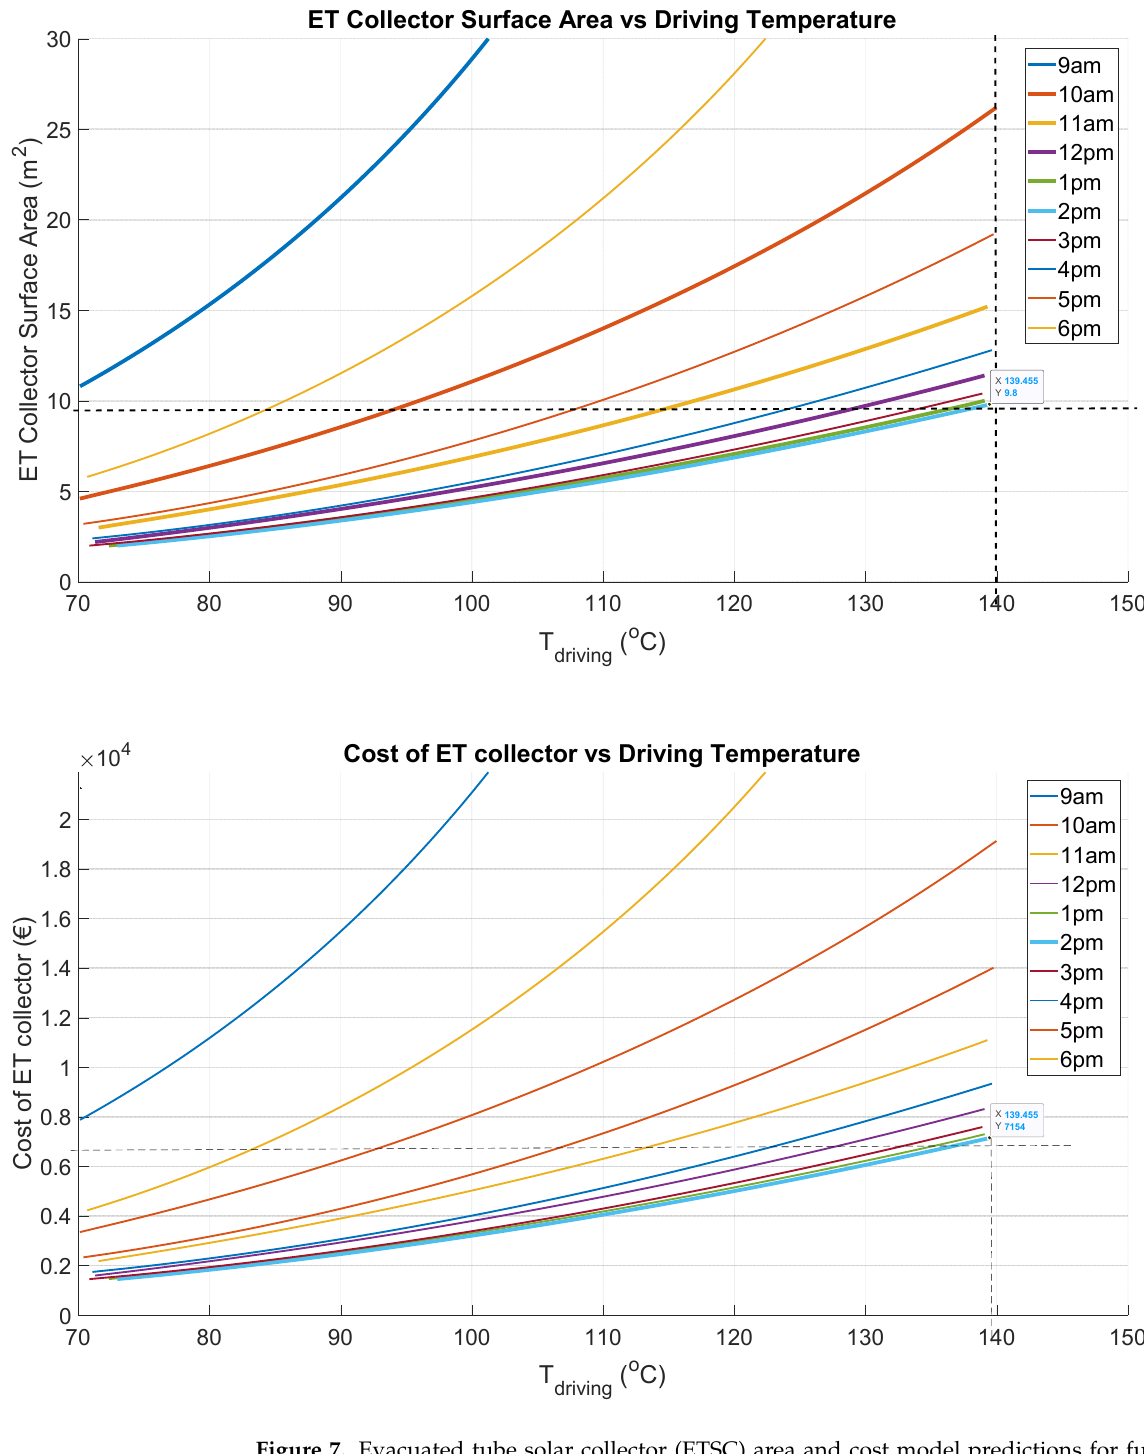
Figure 7. Evacuated tube solar collector (ETSC) area and cost model predictions for function of driving temperature. Table 5. Air conditioning performance with FPTSC (A col = 17.6 m 2 ) on the hottest day (5 April).